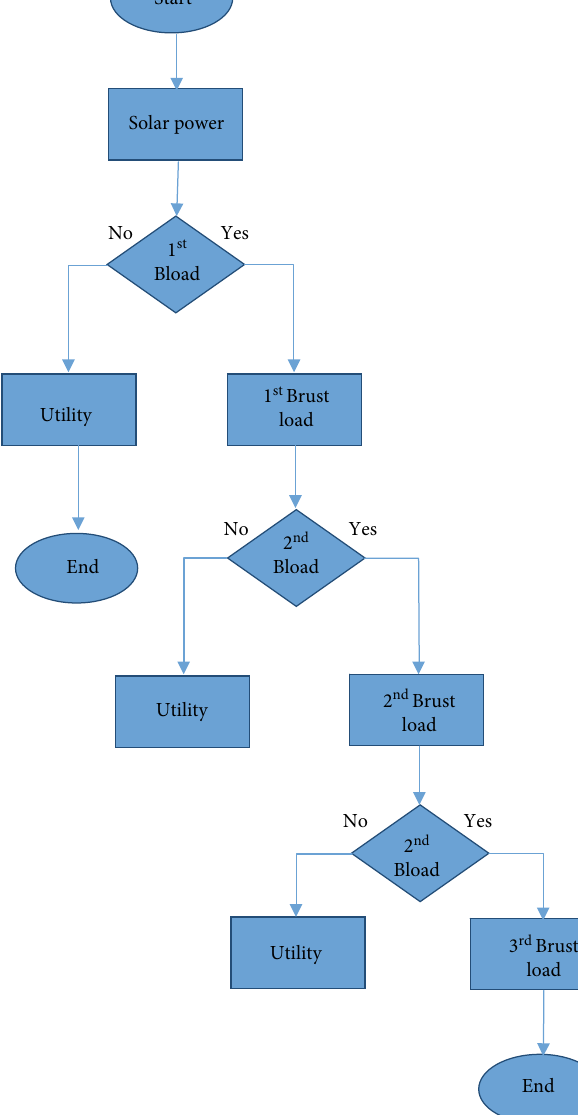
Figure 19: Burst load controller fl